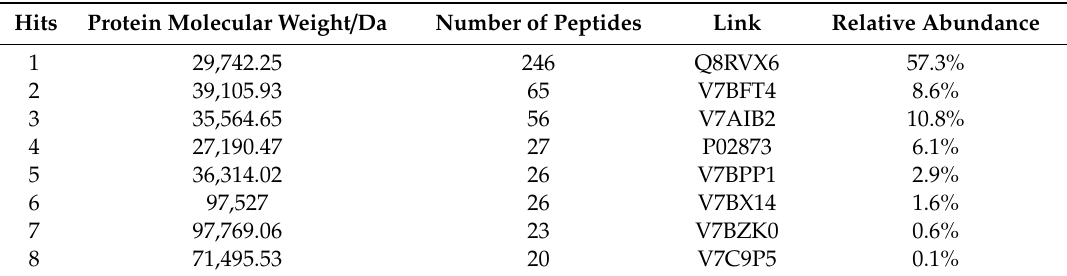
Table 1. The test results of the lectin sample by liquid chromatography-nano electrospray ionization mass spectrometry (Nano LC-ESI-MS/MS).